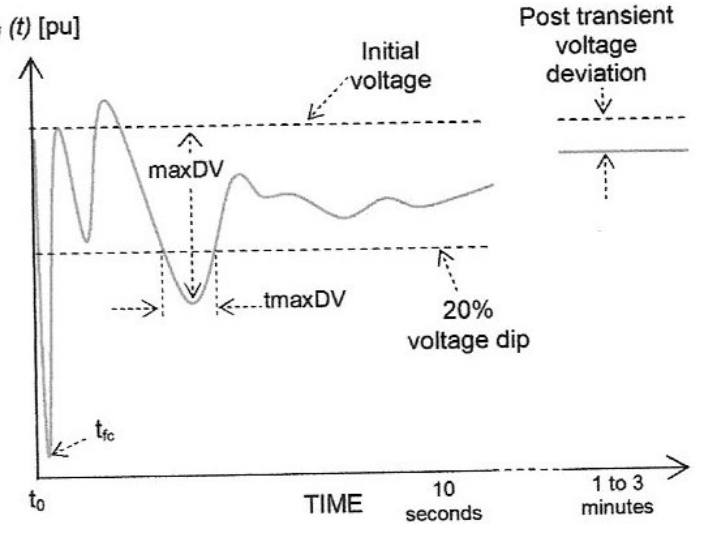
Figure 4. WSCC transient voltage performance parameters [10] at bus i.